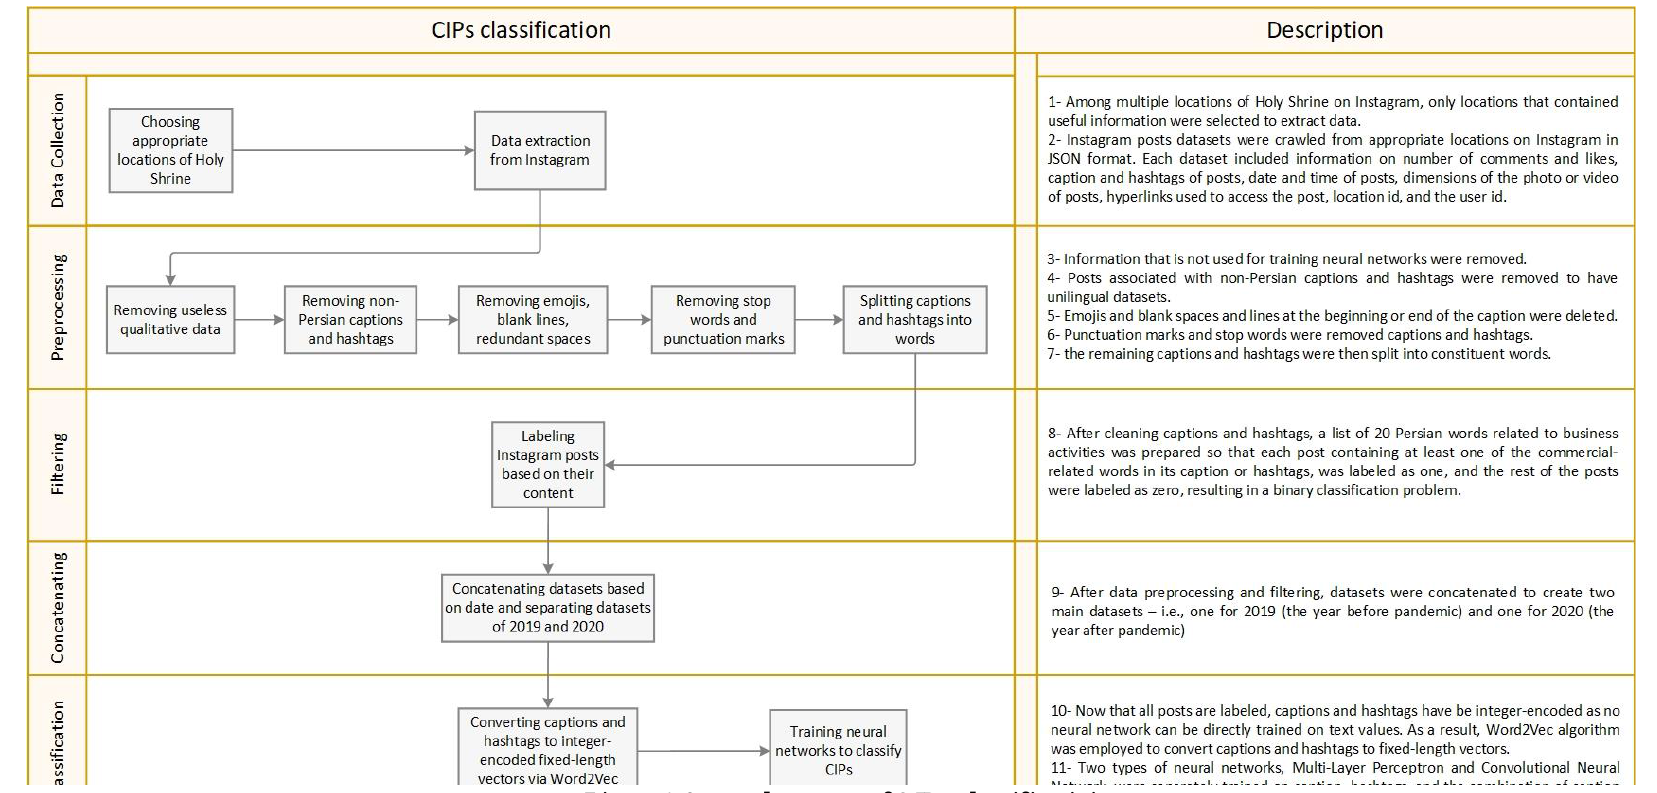
Figure 1 General process of CIPs